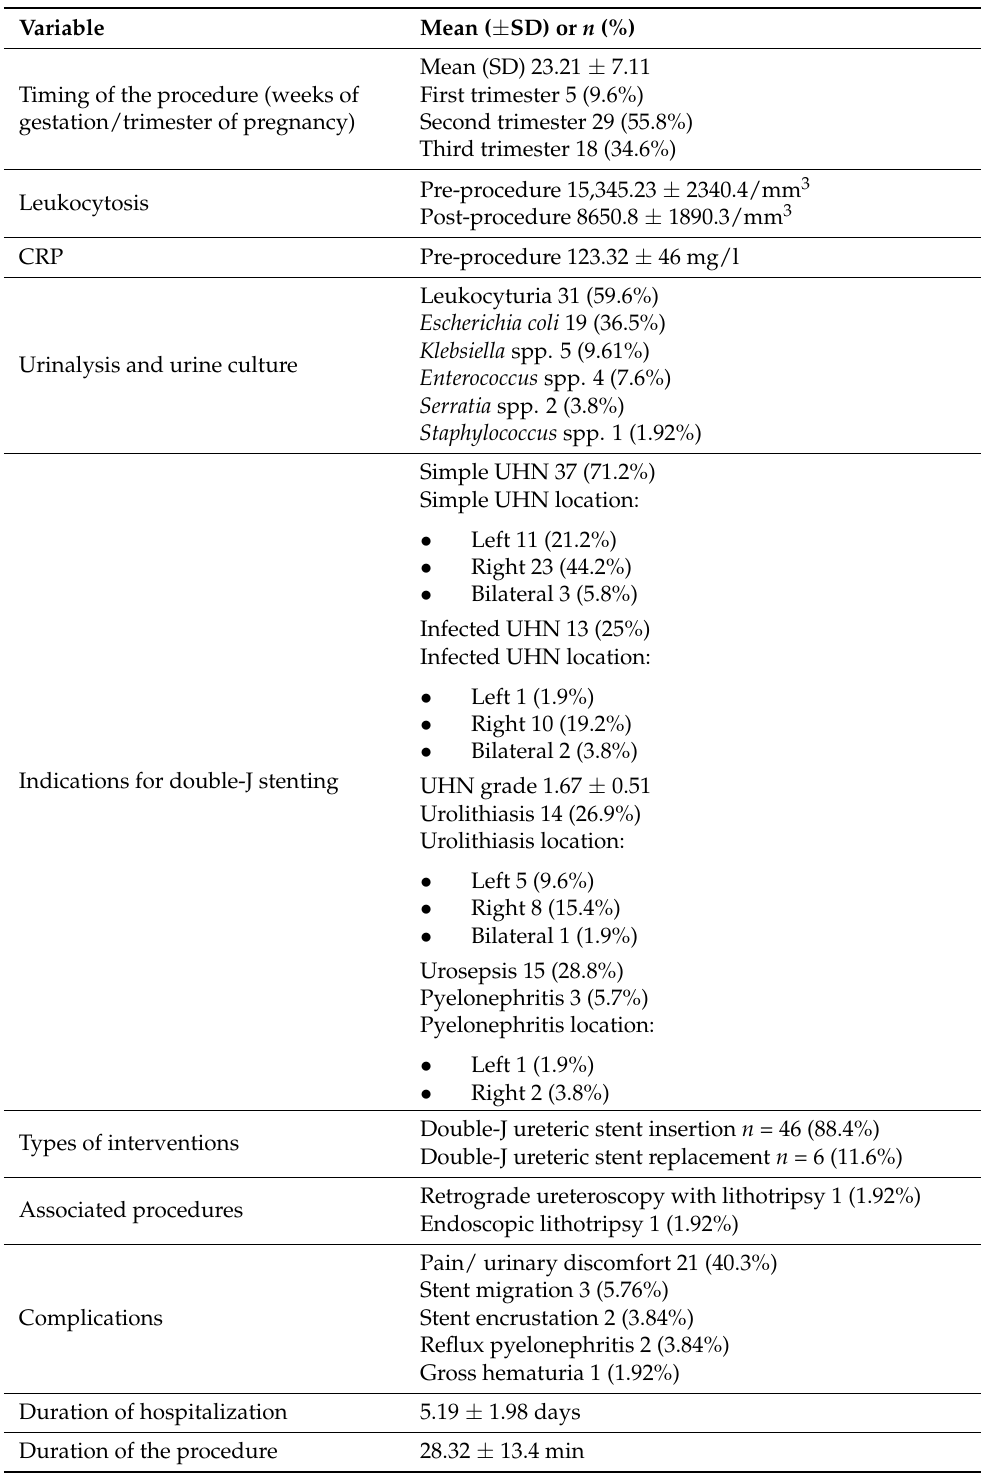
Table 3. Summary of double-J ureteric